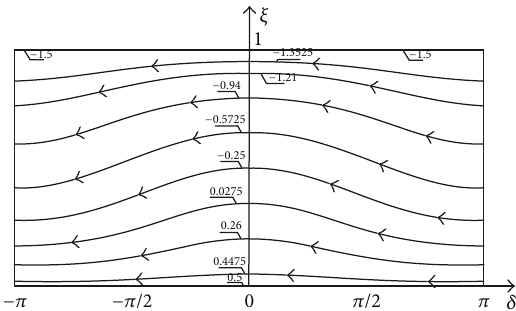
Figure 11: Phase portrait for the case of 1:1 internal resonance 𝜔 1 = 𝐾 = 0 and 𝐾 𝑏 −1 = 1 𝜔 3 at 2 3